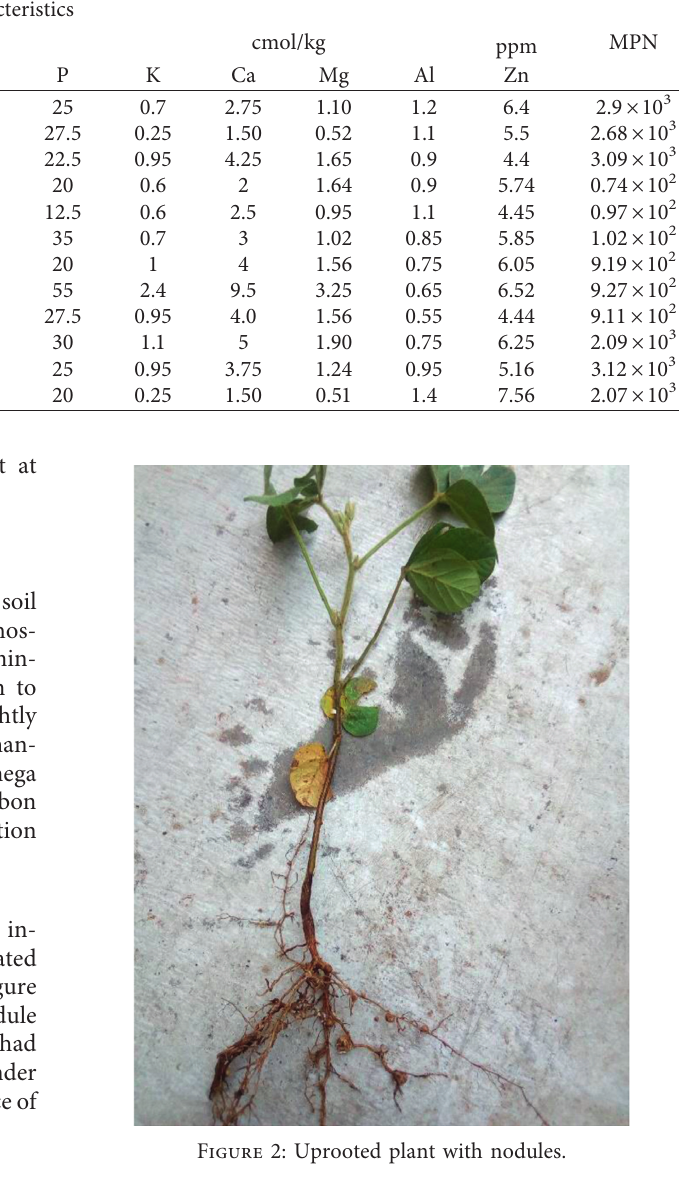
Table 1: Soil properties collected from four regions and the most probable numbers of bacteria. Soil